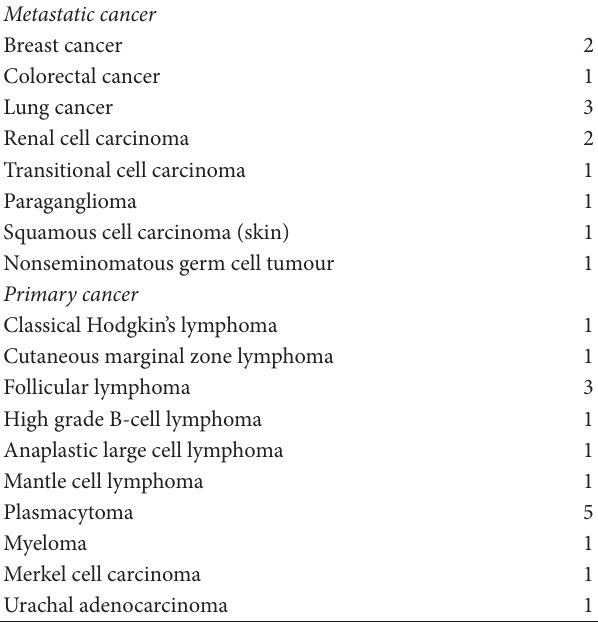
Table 6: Nonsarcomatous cancer